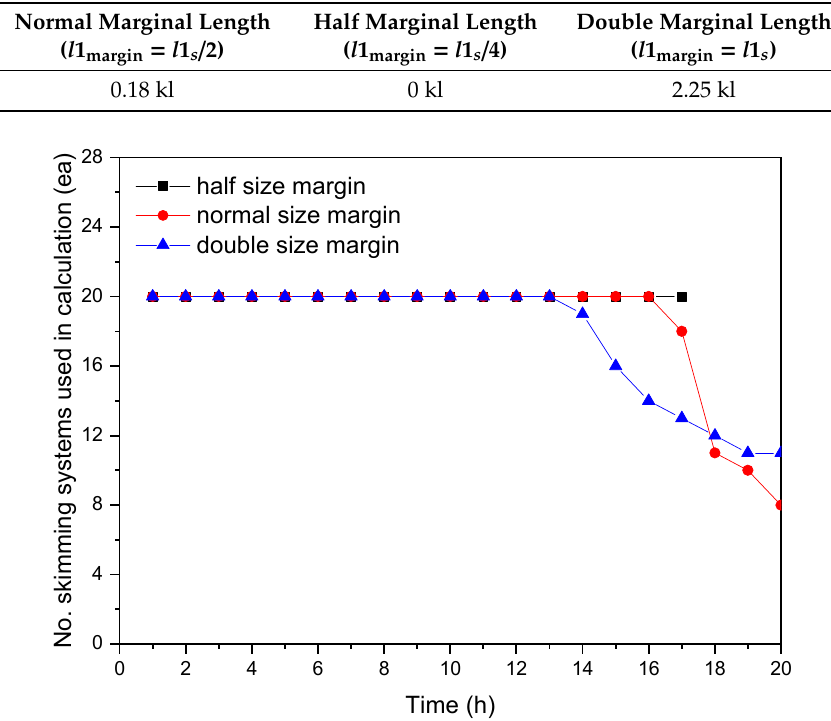
Figure 13. Effect of marginal length on the number of skimming systems (uncertainty of SNR model for 500 kl spill case study).